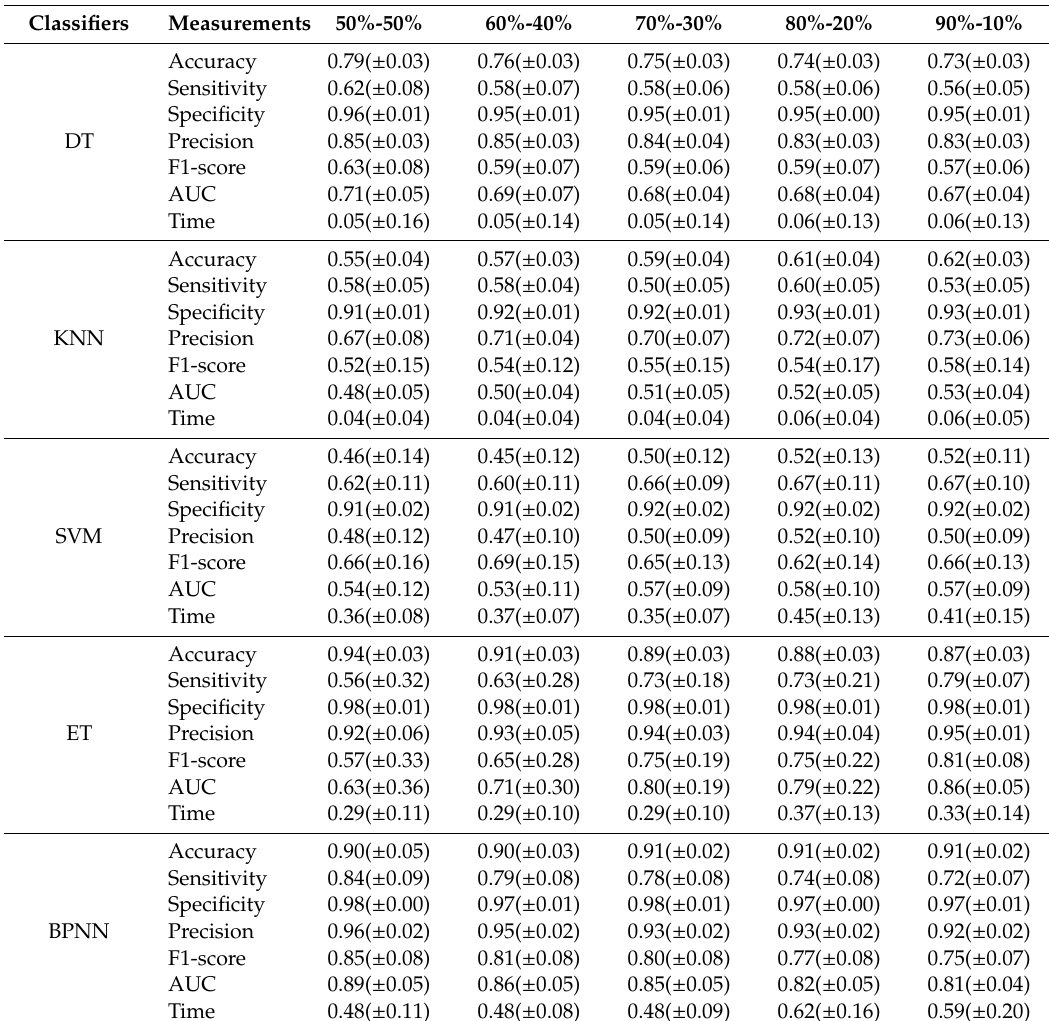
Table 6. Comparison of performance measurements generated by five di ff erent classifiers for second-stage